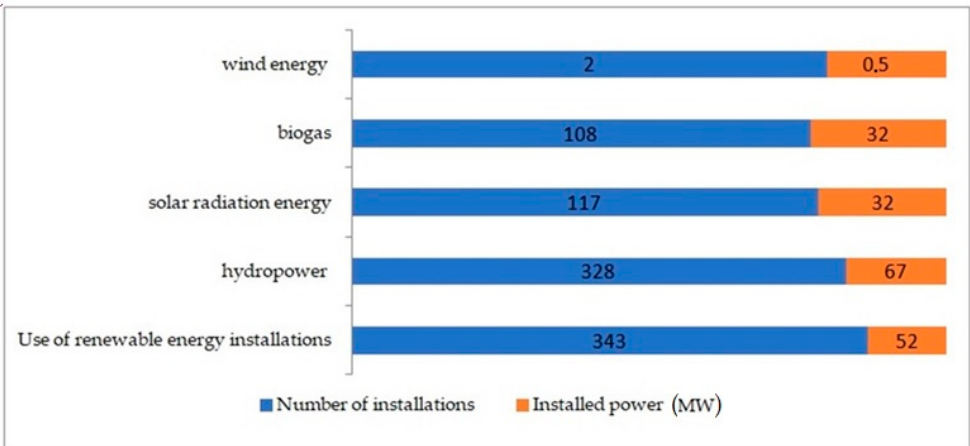
Figure 15. RES installations by source (as of the end of 2020) [60].